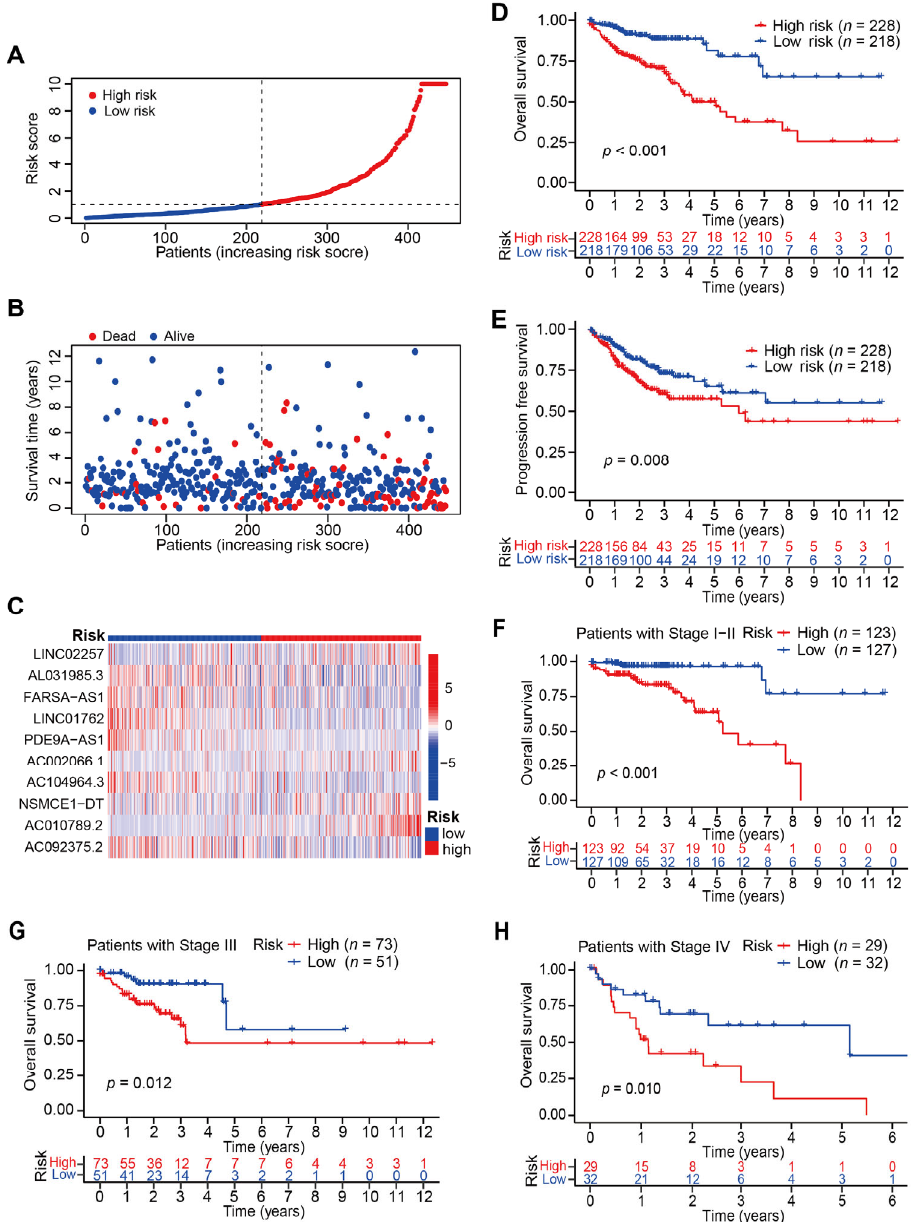
Figure 3. Survival analysis for CC patients based on cuproptosis ‐ prognosis ‐ related LncRNAs. ( A , B ) Distribution and survival status of CC patients with different CRLs ‐ risk score. ( C ) Heatmap for the expression profiles of 10 CRLs. ( D ) Kaplan–Meier survival curve of OS in CC patients with high/low CRLs ‐ risk score ( p < 0.001). ( E ) Kaplan–Meier survival curve of PFS in CC patients with high/low CRLs ‐ risk score ( p = 0.008). ( F ) Kaplan–Meier survival curve of OS in stage I ‐ II CC patients with high and low CRLs ‐ risk score ( p < 0.001). ( G ) Kaplan–Meier survival curve of OS in stage III CC patients with high and low CRLs ‐ risk score ( p = 0.012). ( H ) Kaplan–Meier survival curve of OS in stage IV CC patients with high and low CRLs ‐ risk score ( p = 0.010).